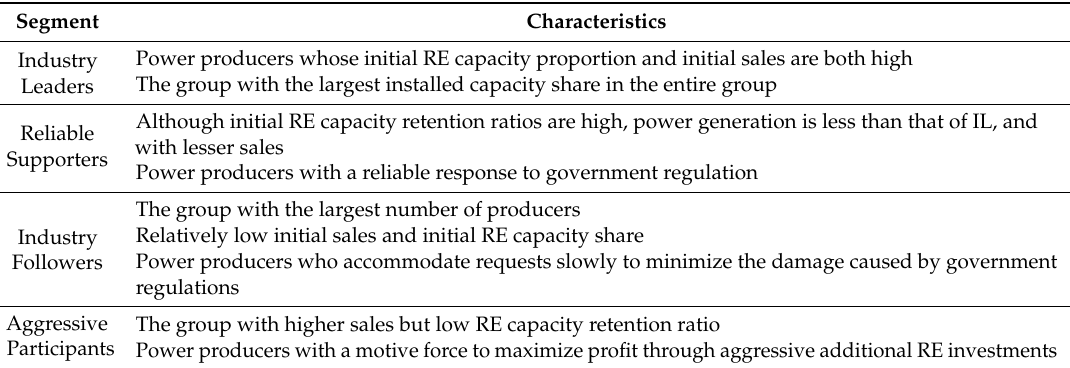
Figure 7. Power producer type matrix. Table 7. Characteristics of each segment.